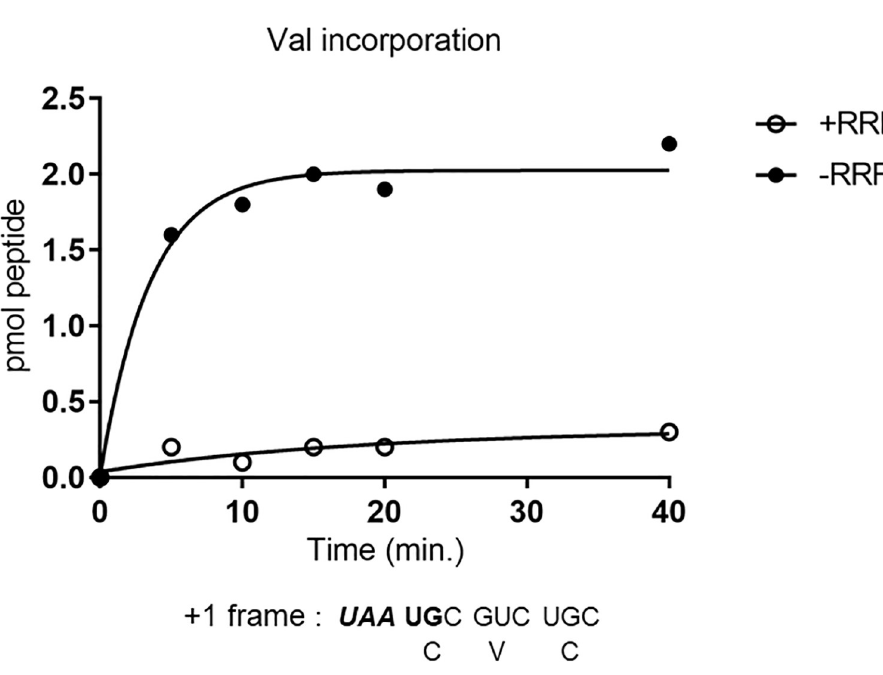
Fig 11. RRF prevents wrong downstream reading in frame with UAA ; RRF releases ribosomes from UAA of UAA UG. Downstream reading in frame with UAA of the junction sequence was measured by [ 14 C]-Valine incorporation coded for by triplet GUC which was in frame with UAA . The components of the reaction mixture were identical to that of Fig 9 except for labeled amino acid (valine).